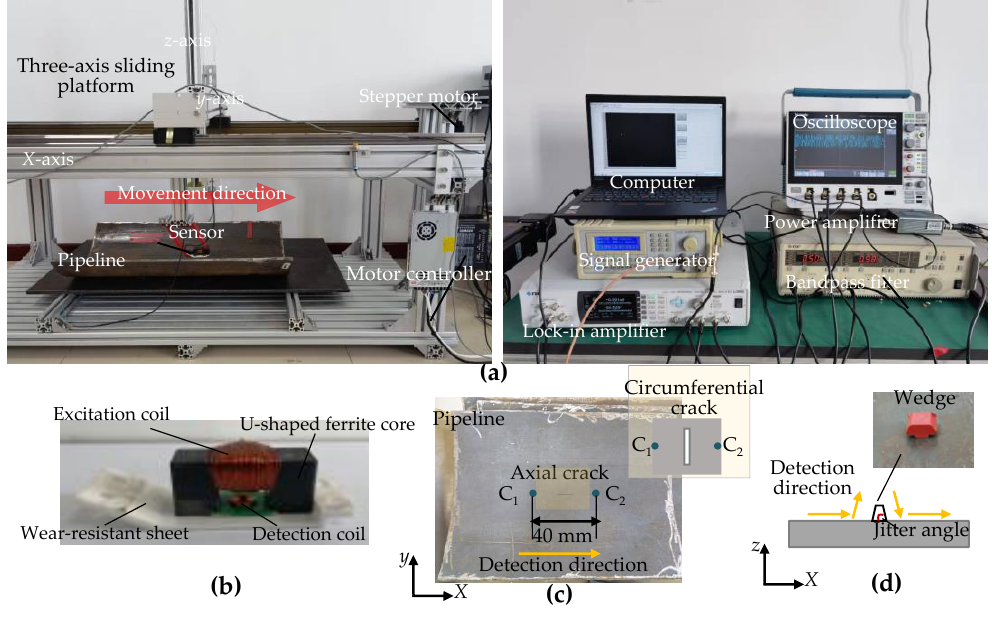
Figure 10. Experimental platform and sensor movement path: ( a ) Detection experimental platform; ( b ) Balance-field electromagnetic technique sensor ( c ) Experimental pipeline physical and movement path of the sensor for the crack detection experiment; ( d ) Movement path of simulated sensor jitter experiment.